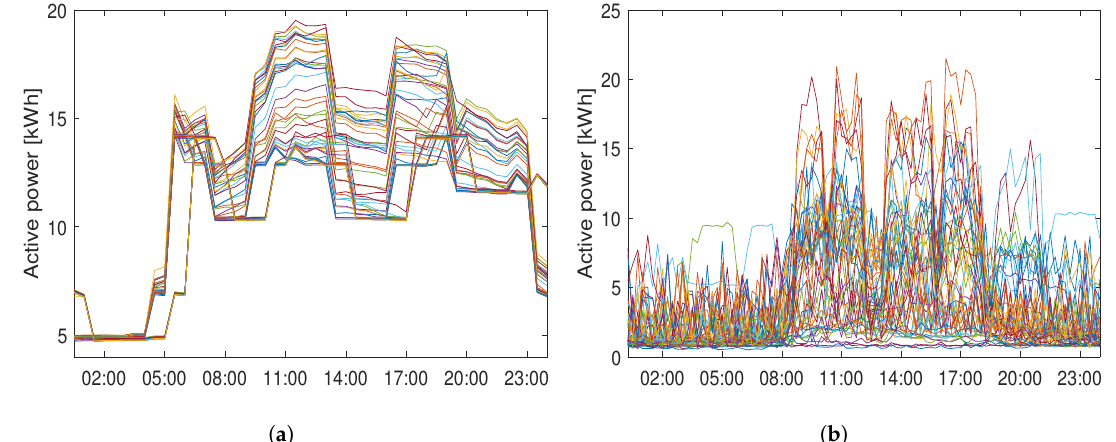
Figure 6. Example of data used in performance evaluation (every Monday for one year). ( a ) DOE; ( b ) KEPCO-high voltage.